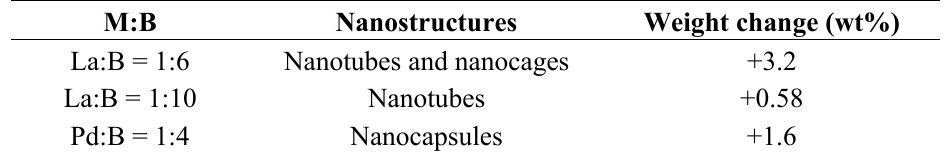
Table 2. Atomic ratio of starting materials, produced structures and hydrogen storage.